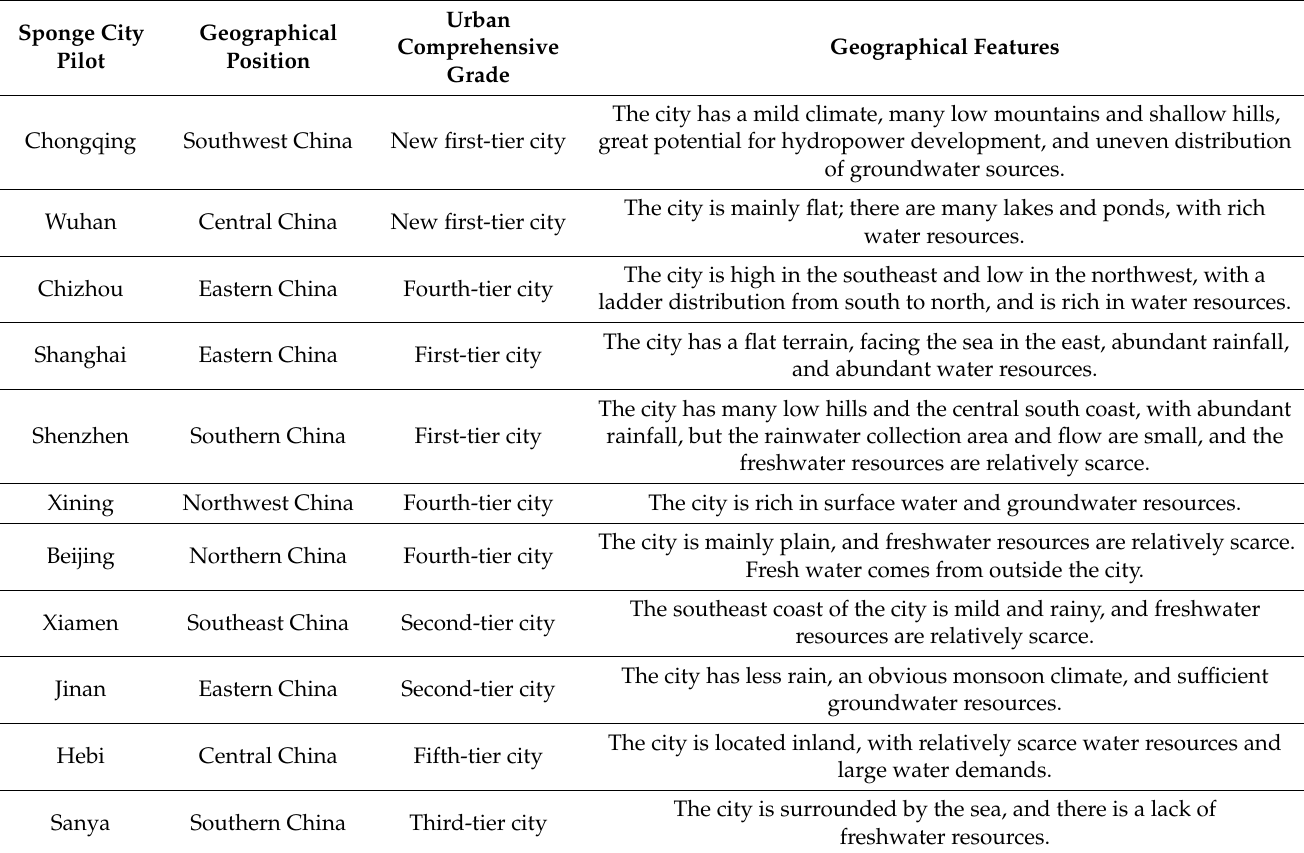
Table 2. Geographic location and characteristics of the selected